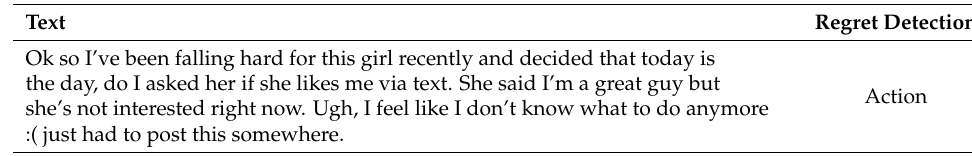
Table 2. Sample texts from ReDDIT dataset.